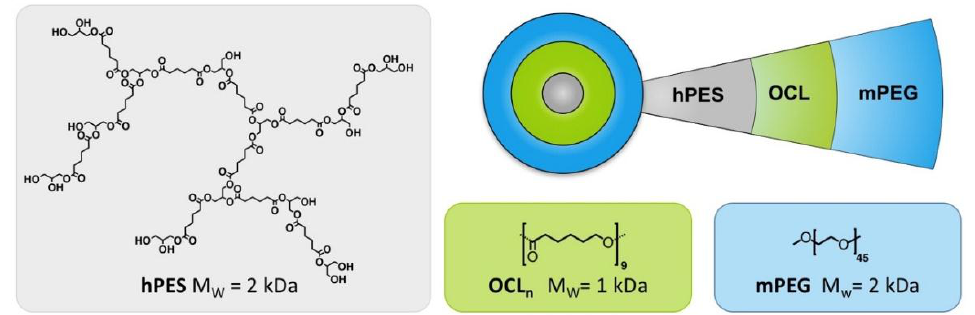
Figure 2. Building blocks and schematic representation of water-soluble CMS nanocarriers based on polyesters.